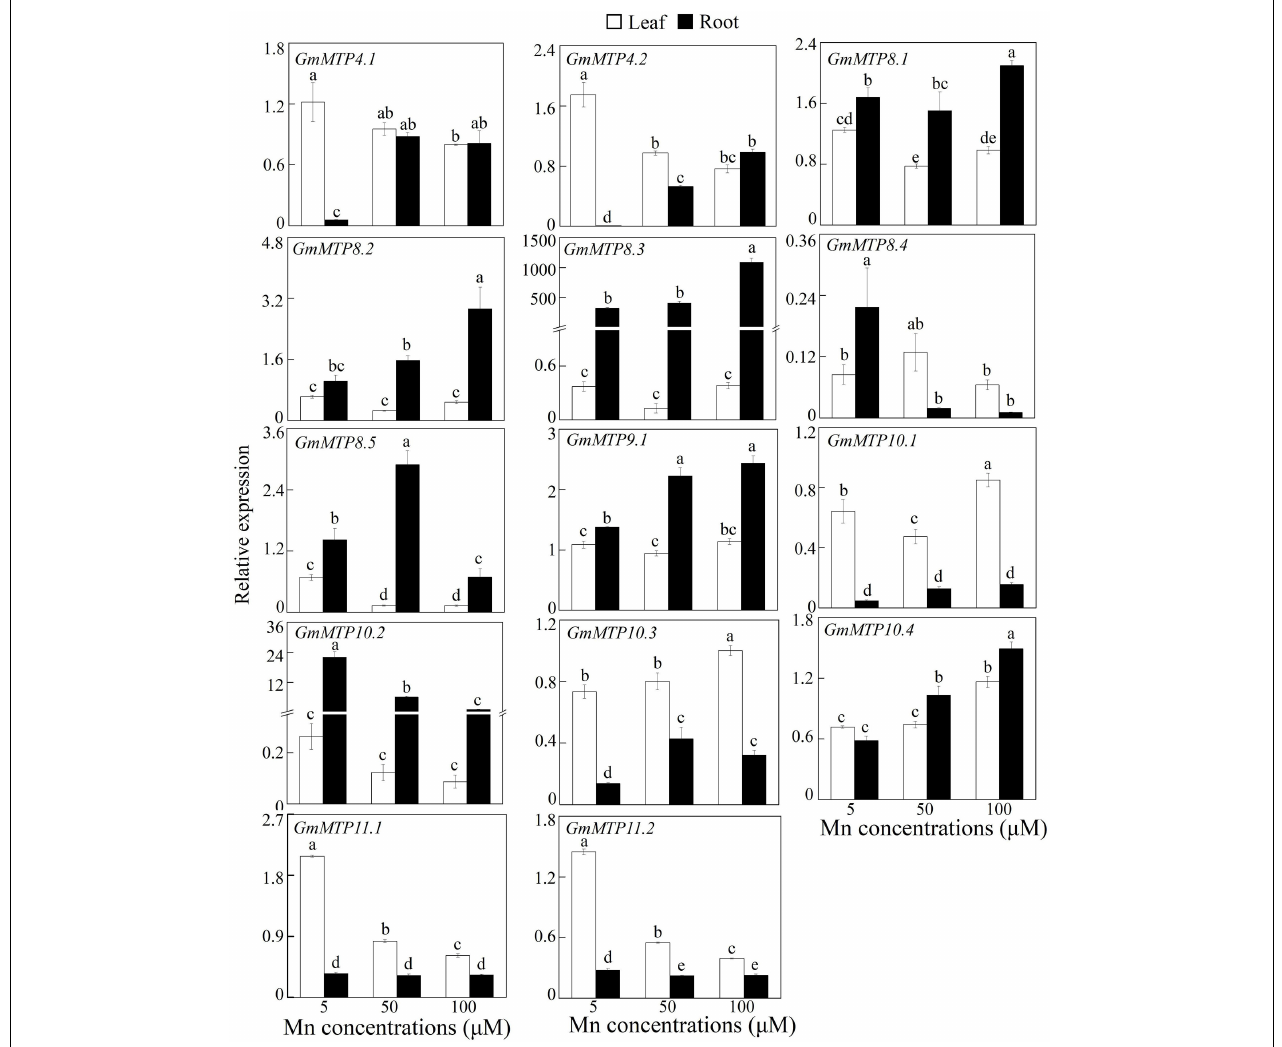
FIGURE 5 | Expressions of GmMTPs in leaf and root of soybean under excess Mn treatments. Fourteen-day-old soybean seedlings were transferred into a nutrient solution containing 5, 50, or 100 µ M MnSO 4 . Five µ M MnSO 4 was used as the control. After 7 days of Mn treatment, leaves and roots were harvested separately for gene expression analysis. Each bar represents the mean value of three independent replicates with standard error. White and black bars represent leaf and root, respectively. Different lower case letters indicate significant differences at P < 0.05.